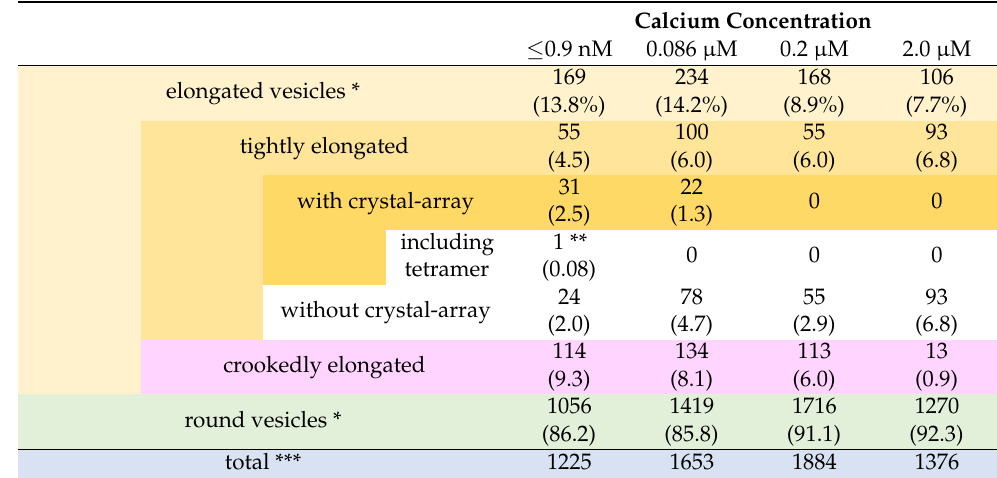
* Elongated and round vesicles are classified based on the ratio of their major axes to minor axes ≥ 2 and < 2 respectively. ** The image of this tetramer-array vesicle is shown in Figure 3b. *** Significantly agglomerated vesicles were not counted (see text for